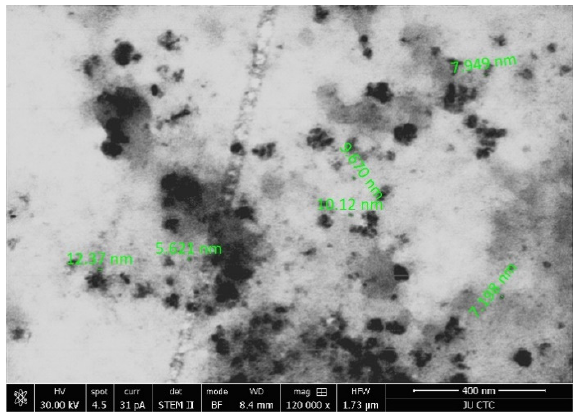
Figure 4. HRTEM images of the nanoparticles.